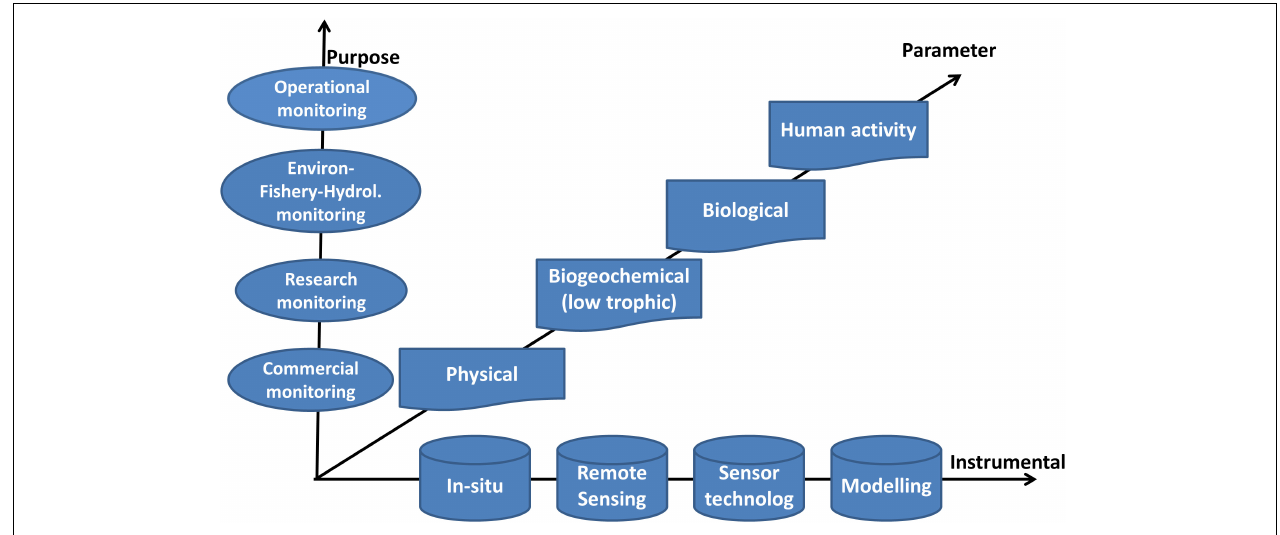
FIGURE 1 | Integrated observing – unlocking the value of ocean observing by integrating observations in three dimensions: fit-for-purpose, parameter, and